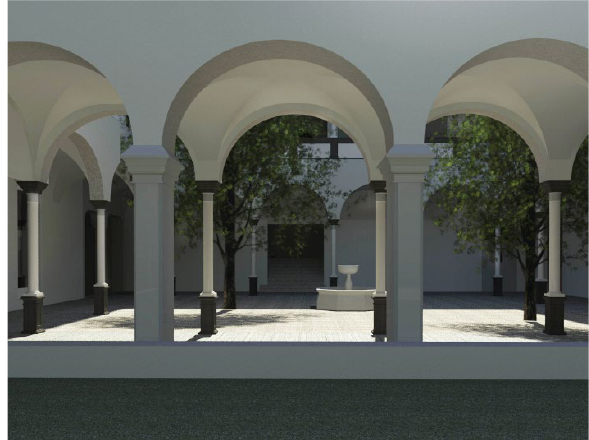
Figure 2. View of the Patio, ground floor – HBIM model